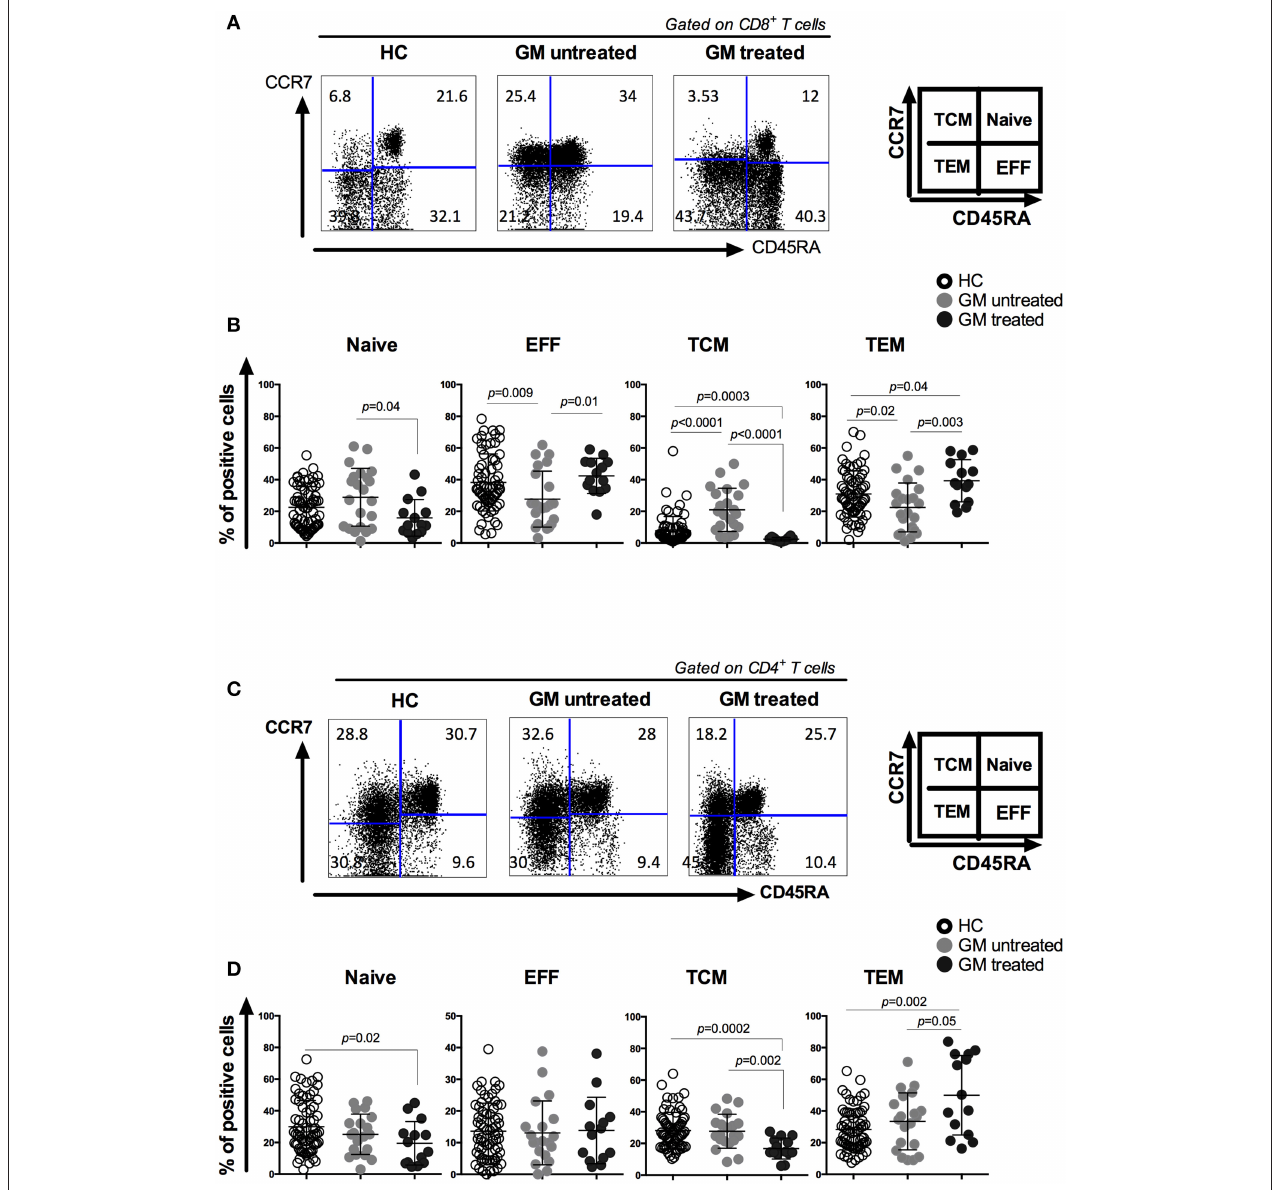
FIGURE 1 | CD8 and CD4T cells from GM treated patients have increased effector memory T cell compartment associated with a decreased central memory one as compared to both GM untreated patients and HC group. Representatives of CD8 (A) and CD4 (C) T cell subsets from one GM treated RA patient, one GM untreated patient and a gender- and age-matched control individual. CD8 and CD4T cells were subgrouped into naïve (T N ), effector (T E ), central memory (T CM ) and effector memory (T EM ) subpopulations by using anti-CD45RA and anti-CCR7 antibodies. Pooled data of T N , T E , T CM , and T EM subpopulations in CD8 (B) and CD4 (D) T cells from GM untreated patients ( n = 23), GM treated patients ( n = 14) and control individuals ( n = 68). Horizontal lines indicate mean